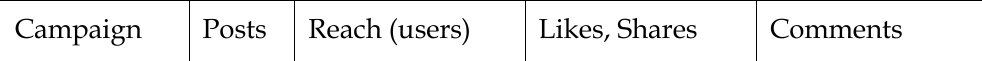
Table 3: Government posts and citizen inputs on Facebook (Urna de Cristal, 2017)